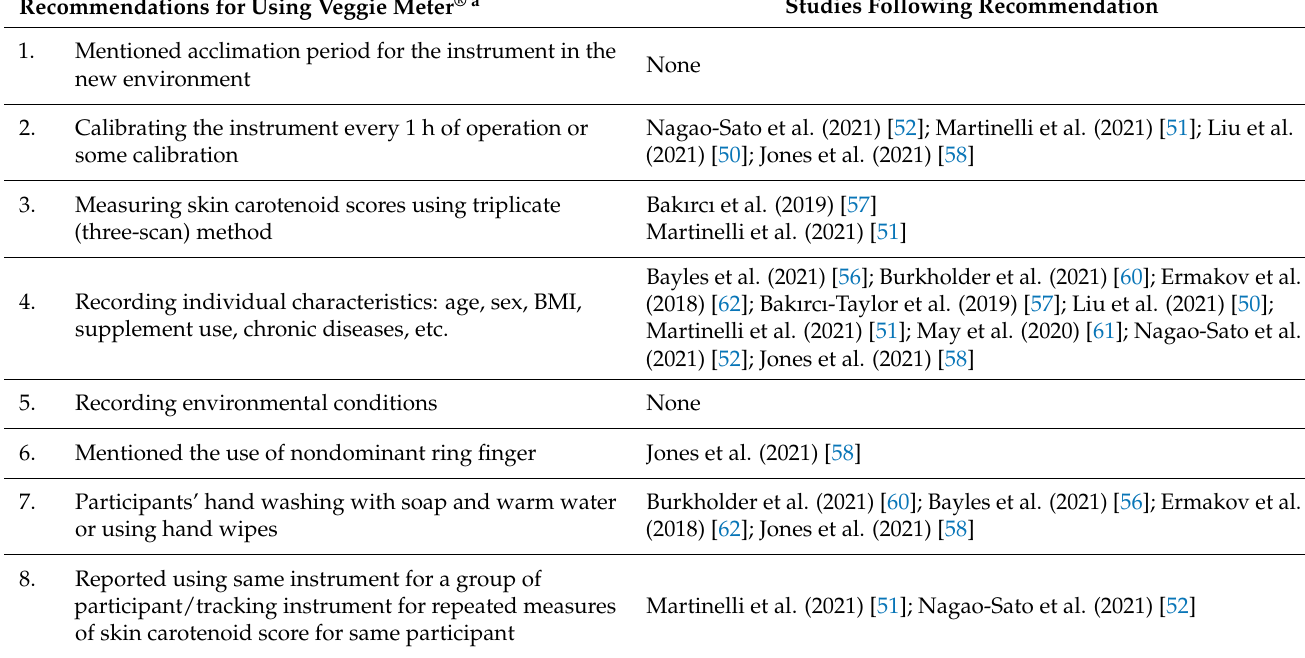
Table 2. Reported Veggie Meter ® protocol to assess skin carotenoids in included studies compared to recommended protocol